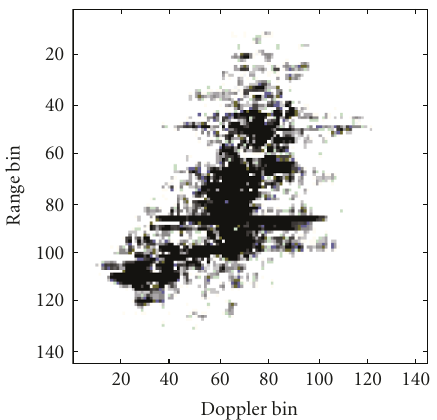
Figure 3: ISAR images of real data based on the range-Doppler